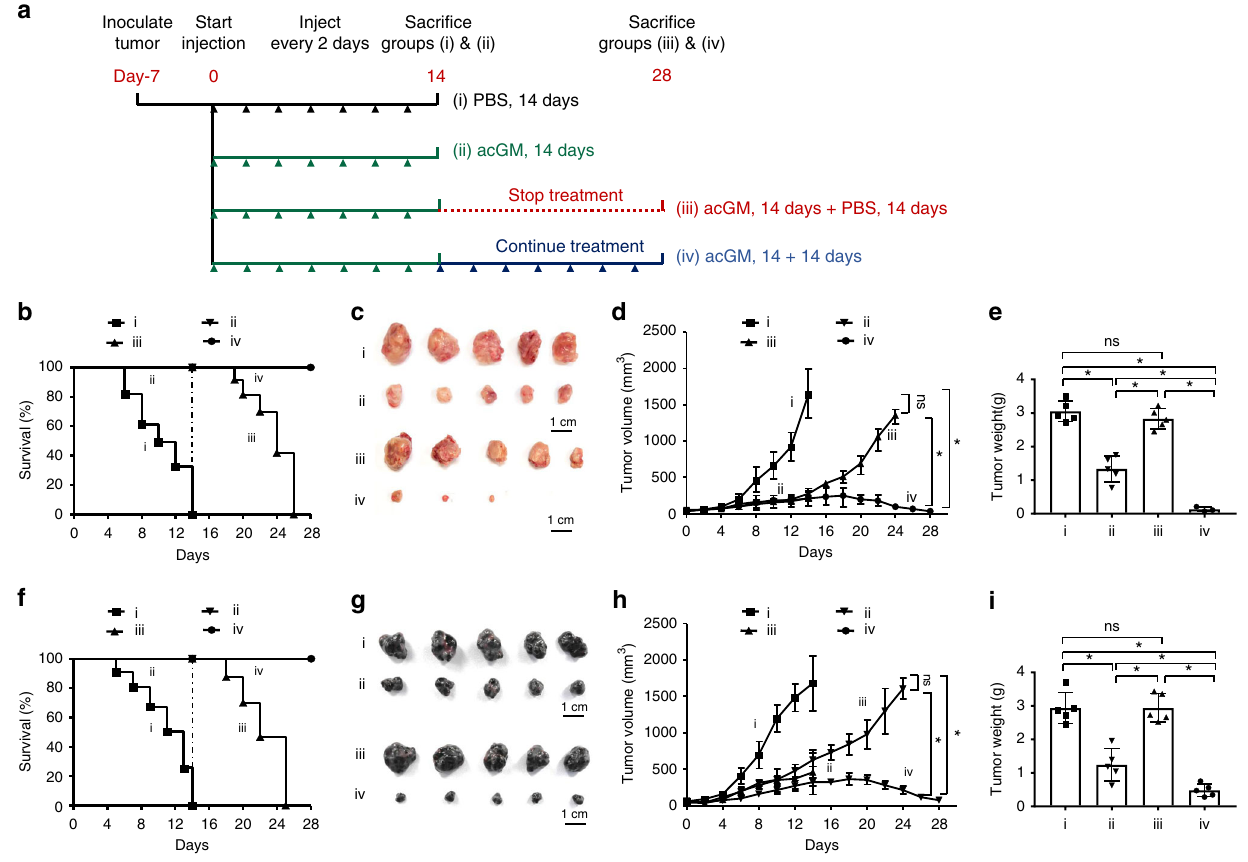
Fig. 5 acGM-1.8 suppress the growth of two tumor models in mice. a Schematic illustration of the treatment procedure of acGM-1.8 in two types of tumors, S180 sarcoma and B16 melanoma, growing in mice. When the tumor diameter reached 0.5 cm, the mice were randomly divided into four groups and treated with: i) PBS for 14 days; ii) acGM-1.8 (10 mg/kg) for 14 days; iii) acGM-1.8 (10 mg/kg) for 14 days and then PBS for 14 days; iv) acGM-1.8 for 28 days. PBS or acGM-1.8 was intratumorally injected every two days. b Survival ratio of the S180 sarcoma-bearing mice in the four groups. c Gross view of the S180 tumor samples. d Measurement of the S180 tumor size. e Measurement of the S180 tumor weight. f Survival ratio of the B16 melanoma-bearing mice in the four groups. g Gross view of the B16 tumor samples. h Measurement of the B16 melanoma tumor size. ( i ) Measurement of the B16 melanoma tumor weight; * P < 0.05 between the two compared groups; ns: no signi fi cance; n =